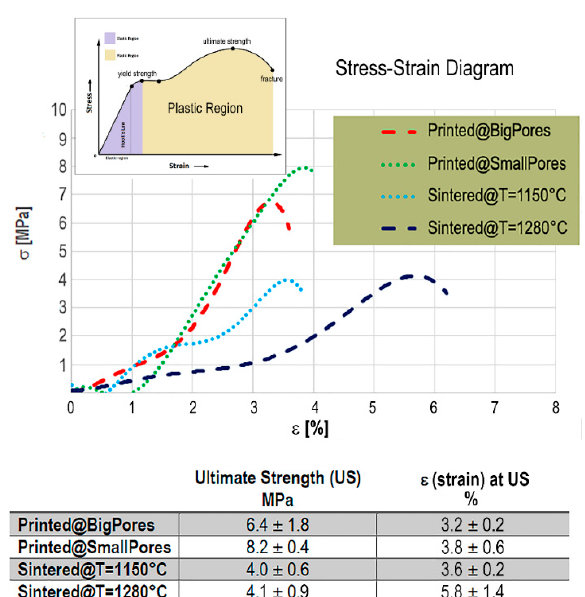
Figure 3. Top: stress ( σ )–strain ( ε ) profiles of the investigated biomaterials. Bottom: Ultimate strength (mean ± SD, expressed in MPa) vs. ε (mean ± SD, expressed in %). The SLA-3D-printed samples with small pores (Printed@SmallPores samples) showed higher ultimate compressive strength with respect to SLA-3D-printed samples with big pores (Printed@BigPores samples). In the traditionally sintered samples, the strain ε at the yield point is around 1.4–1.6%, independent of the sintering temperature; however, despite a very similar ultimate strength (~4 MPa), the strain achieved there by the Sintered@ T = 1280 ◦ C samples was significantly larger than in Sintered@ T = 1150 ◦ C